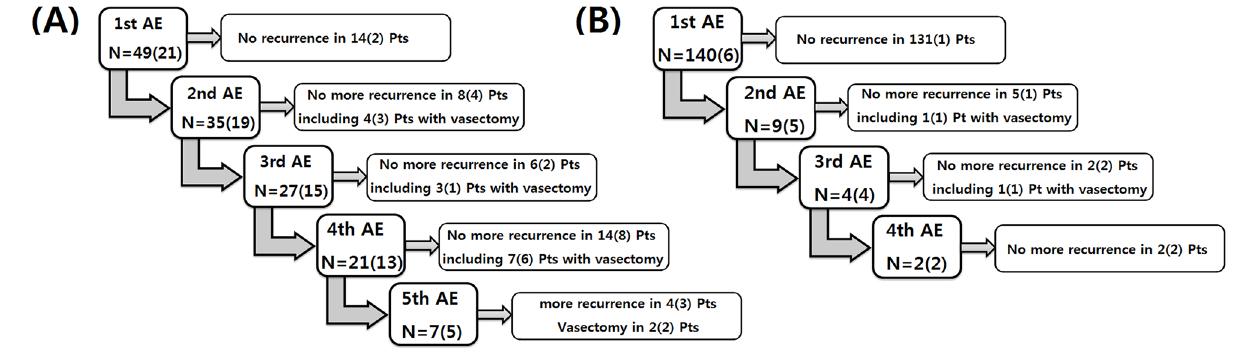
Fig 2. Recurrence of epididymitis in the known genitourinary anomaly group (A), and the unknown genitourinary anomaly status group (B). The number in the parenthesis is the number of patients with cystic dilated prostatic utricles; AE, acute epididymitis; Pt, patient.